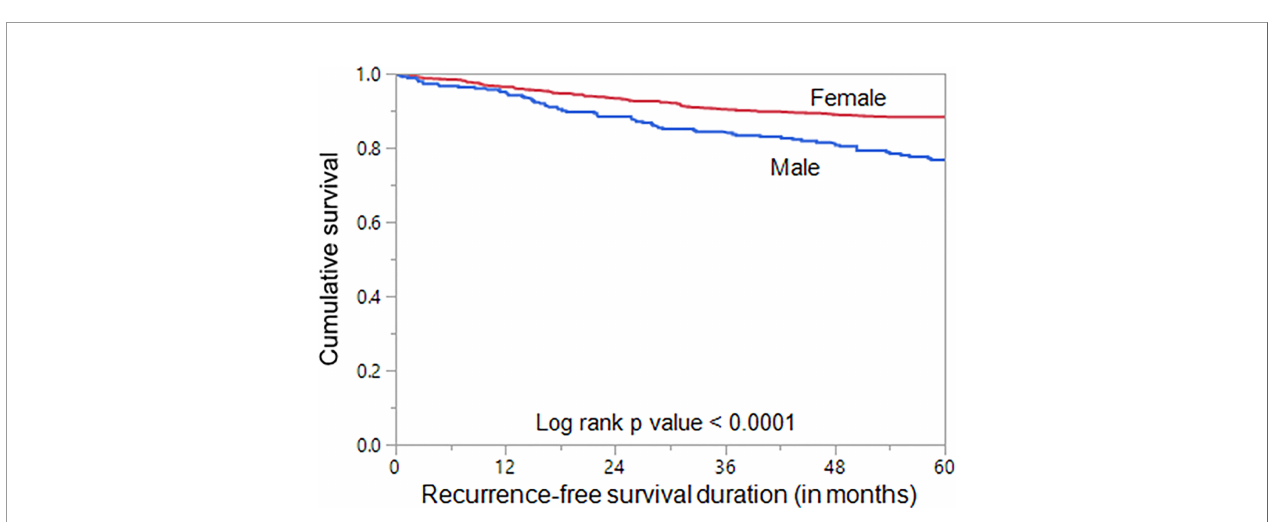
FIGURE 2 | Sex and Recurrence-free survival. Kaplan – Meier survival curve showing poor recurrence-free survival in male sex compared to female sex ( p <